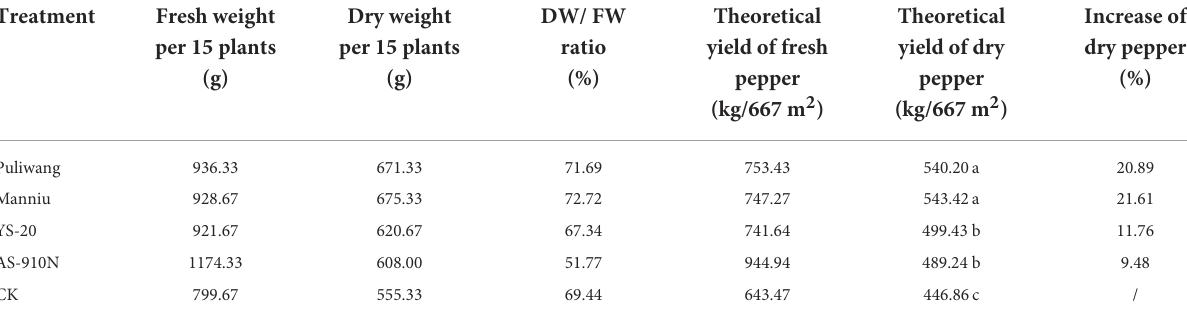
TABLE 6 Effect of aerial sprays using adjuvants on the yield of pepper sprayed by UAVs. Treatment